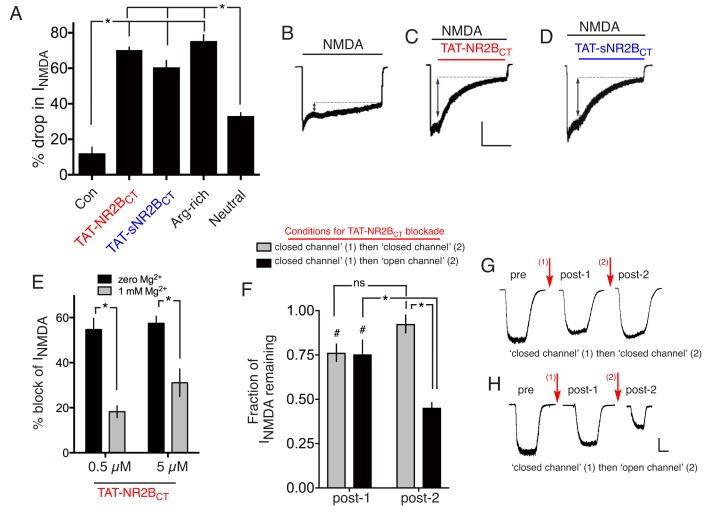
Both TAT-NR2BCT and TAT-sNR2BsCT are direct NMDAR antagonists.(A–D) Both TAT-NR2BCT and TAT-sNR2BCT (scrambled version of TAT-NR2BCT) immediately antagonize NMDAR currents upon extracellular exposure. NMDA-induced currents were recorded under whole-cell voltage clamp, with the indicated peptides (at 5 µM) applied approximately 5 s after NMDA (to allow NMDAR currents to reach steady state). Arg-rich refers to the arginine-rich positively charged peptide; Neutral refers to the neutral peptide-see main text for sequences of these as well as TAT-NR2BCT and TAT-sNR2BCT. NMDA-induced NMDAR currents were monitored for a further 45 s and the percentage drop in currents calculated, compared to no peptide at all (Con) which represents a measure of natural desensitization over this period. p<0.0001 (one-way ANOVA). *p<0.0001, Sidak's post-hoc test (n = 8 of all conditions). Example traces shown in (B) (C) and (D). Scale bar: 15 s, 500 pA. (E) NMDAR antagonism by TAT-NR2BCT is inhibited by Mg2+ blockade. NMDAR currents were measured, after which neurons were incubated in TAT-NR2BCT (5 or 0.5 µM) for 60 s in the presence or absence of 1 mM Mg2+, after which NMDAR currents were measured again (in zero Mg2+, no peptide). p<0.0001 (one-way ANOVA, F(1,22)=47.16 (effect of [Mg2+])). *p<0.0001, p=0.0007, Sidak's post-hoc test (zero Mg2+: n = 6 (0.5 µM), n = 7 (5 µM); 1 mM Mg2+: n = 6 (0.5 µM), n = 7 (5 µM)). (F–H) NMDAR antagonism by TAT-NR2BCT is more effective on open channels. See main text for experimental details. p<0.0001 (two-way ANOVA, comparing initial current with subsequent measurements: F (2, 45)=25.22. p<0.0001 (two-way ANOVA, comparing 'closed-then-closed' protocol (grey bars, n = 8) with 'closed-then-open' protocol (black bars, n = 9): F (1, 45)=18.26. #p=0.003, 0.0009 (Sidak's post-hoc test), comparing to initial currents. *p<0.0001 (Sidak's post-hoc tests), comparisons indicated. (G) shows example recordings taken during the consecutive ‘closed’ then ‘closed’ channel protocol. (H) shows example recordings taken during the consecutive ‘closed’ then ‘closed’ channel protocol. Scale bar = 1 s, 250 pA.DOI:
http://dx.doi.org/10.7554/eLife.17161.01610.7554/eLife.17161.017Figure 3—source data 1.Data relating to Figure 3—figure supplement 1a.DOI:
http://dx.doi.org/10.7554/eLife.17161.01710.7554/eLife.17161.018Figure 3—source data 2.Data relating to Figure 3—figure supplement 1b.DOI:
http://dx.doi.org/10.7554/eLife.17161.01810.7554/eLife.17161.019Figure 3—source data 3.Data relating to Figure 3a.DOI:
http://dx.doi.org/10.7554/eLife.17161.01910.7554/eLife.17161.020Figure 3—source data 4.Data relating to Figure 3e.DOI:
http://dx.doi.org/10.7554/eLife.17161.02010.7554/eLife.17161.021Figure 3—source data 5.Data relating to Figure 3f.